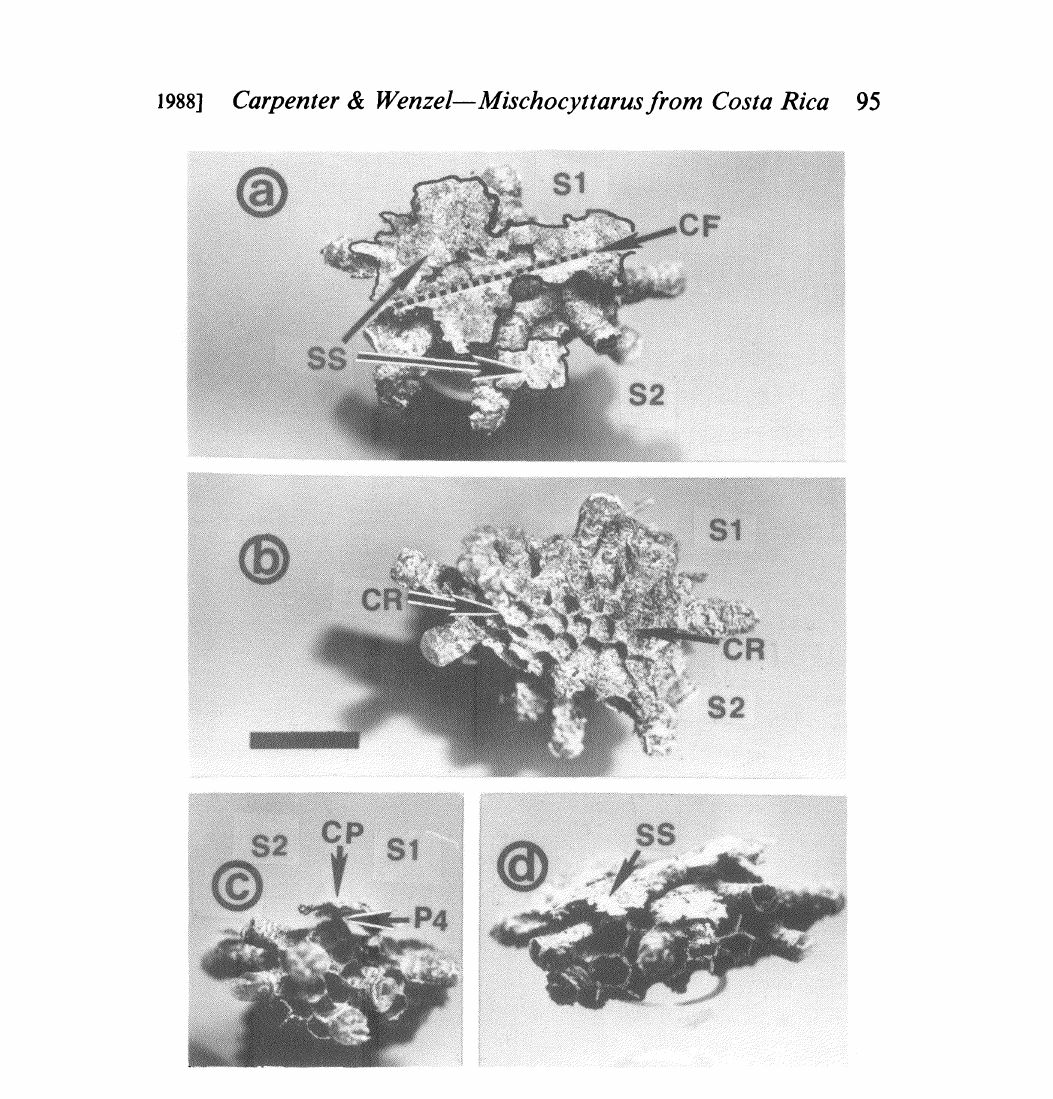
Fig. 8. Nest of M. pelor. 8a: Oblique top view. SS substrate sheet (outlined), CF central furrow, S primary side, $2 secondary side. 8b: Oblique bottom view. CR central row of five downward cells; scale bar equals 10 mm. 8e: Edge view. Cp central plate axis viewed on edge, P4 fourth pedicel. 8d: Retouched to highlight cell walls. SS substrate